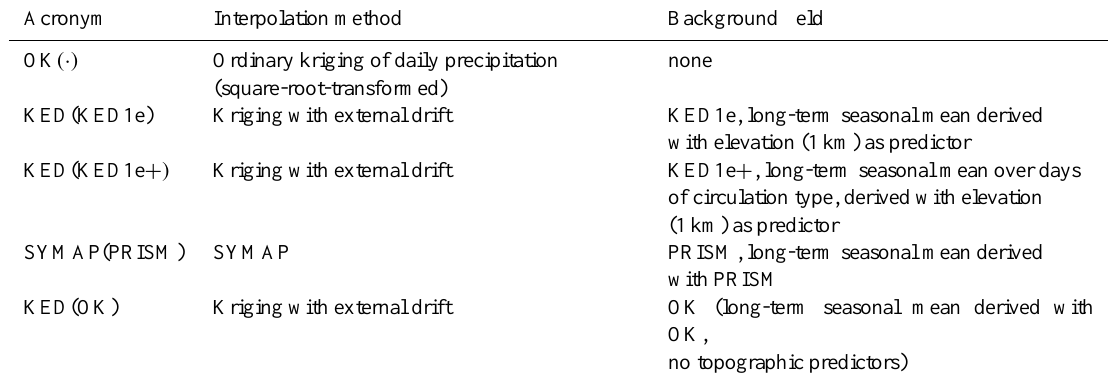
Table 2. Interpolation experiments conducted for daily precipitation. The name of a scheme is a combination of the name of the daily scheme and the background field